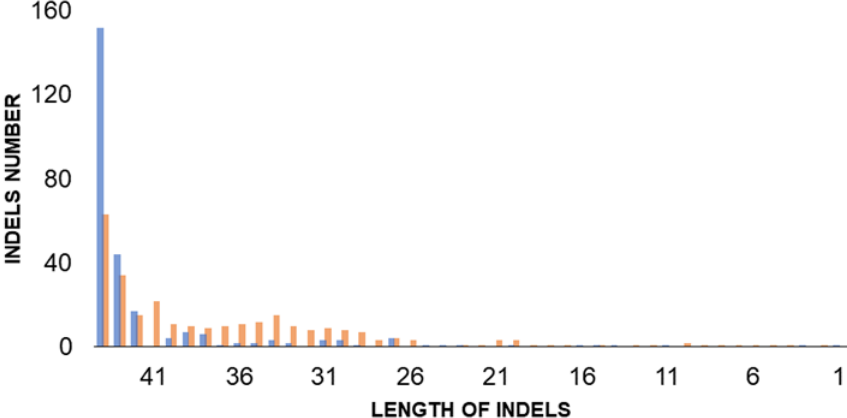
Figure 1. Distribution of indels of different sizes in heterozygous sites in the genome of B. naardenensis CBS 7540. Red columns indicate number of insertions, blue columns show deletions.